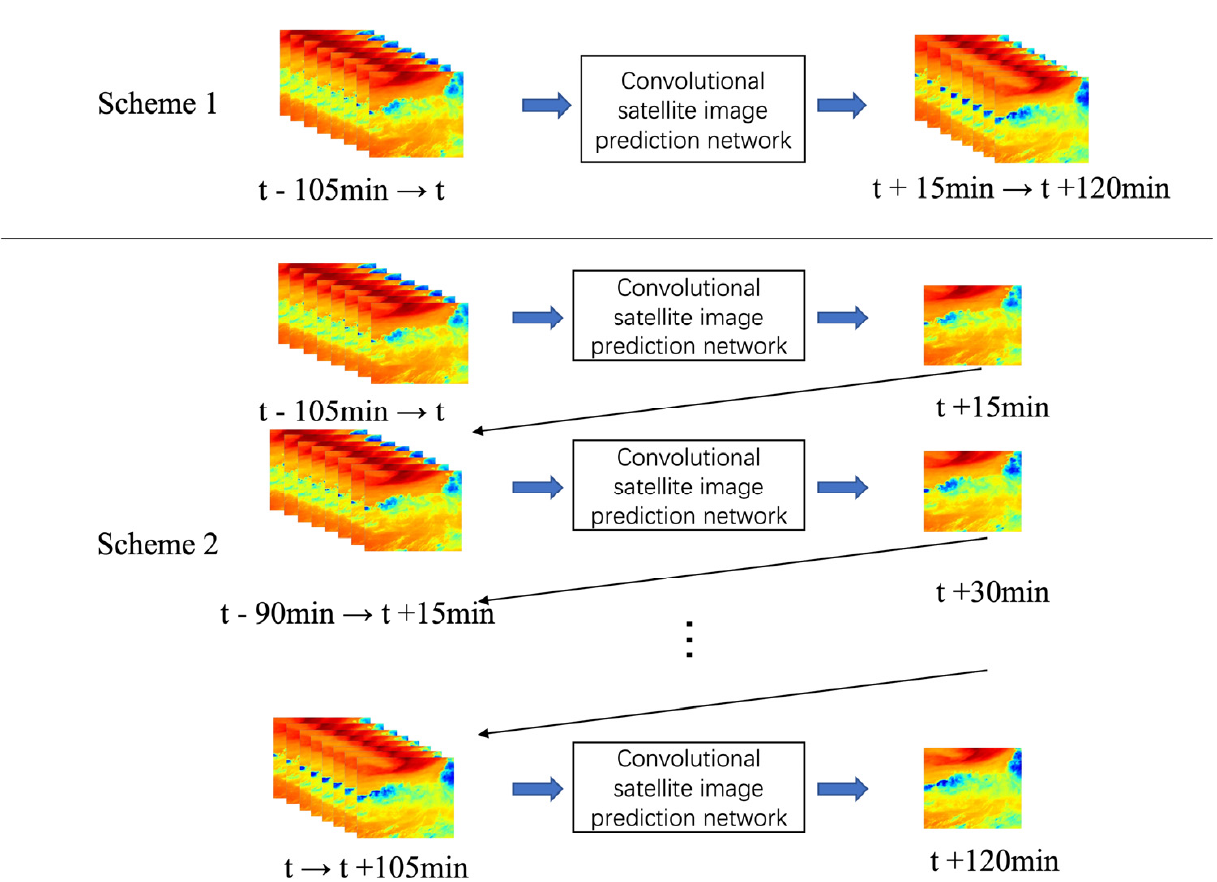
Figure 5. The predictions of the two input schemes.